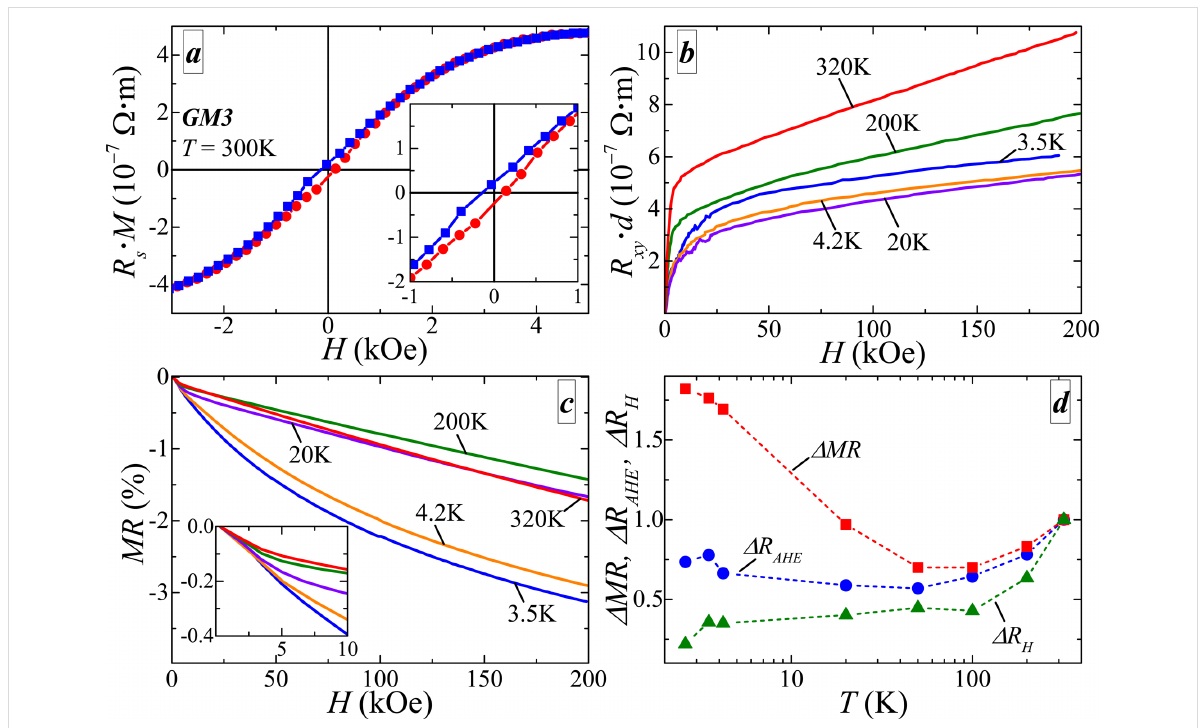
Figure 3: Magnetotransport properties of sample GM3: (a) Field dependence of the anomalous Hall component at 300 K (the linear background is subtracted). The slope of the curve correlates with the sign of the charge carriers (holes), i.e., the observed AHE is positive. The inset demonstrates hysteresis behaviour at low fields. (b) Field dependence of the Hall resistance up to H = 200 kOe at various temperatures. (c) Magnetoresistance at various temperatures. The inset shows the low-field part of the presented curves. (d) Temperature dependence of the high-field magnetoresistance Δ MR (at H = 200 kOe), saturated AHE amplitude Δ R AHE and Hall slope Δ R H normalized by the corresponding values at T = 320